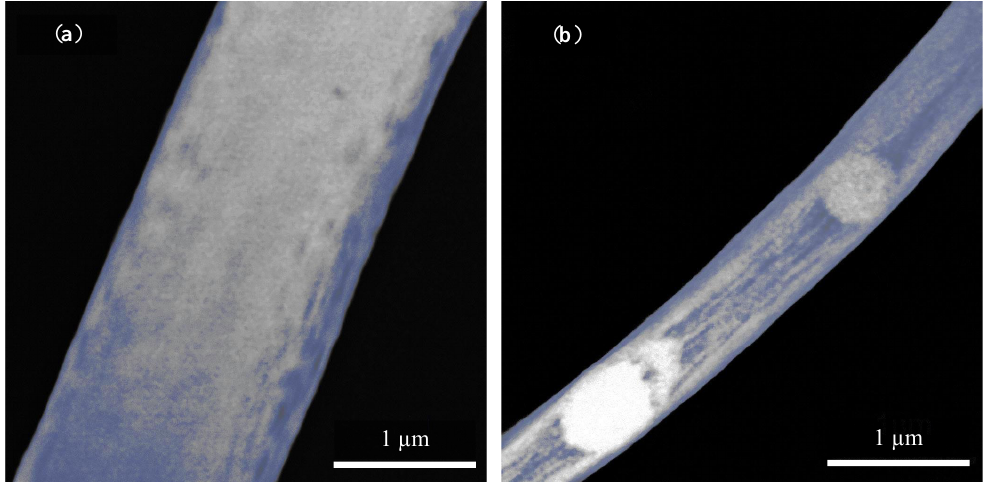
Figure 4. Internal fiber structure at collector speed ( a ) 300rpm and ( b ) 2000rpm observed by STEM detector and HAADF method. The accelerating voltage of 30kV with the current of 50pA and view field of 5µm was used.